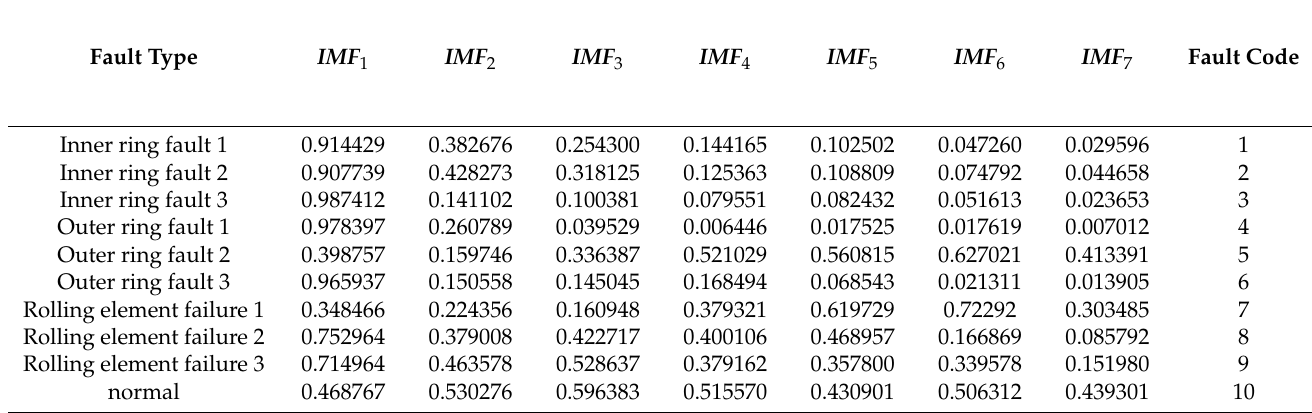
Table 2. IMF correlation coefficient of ten fault types.